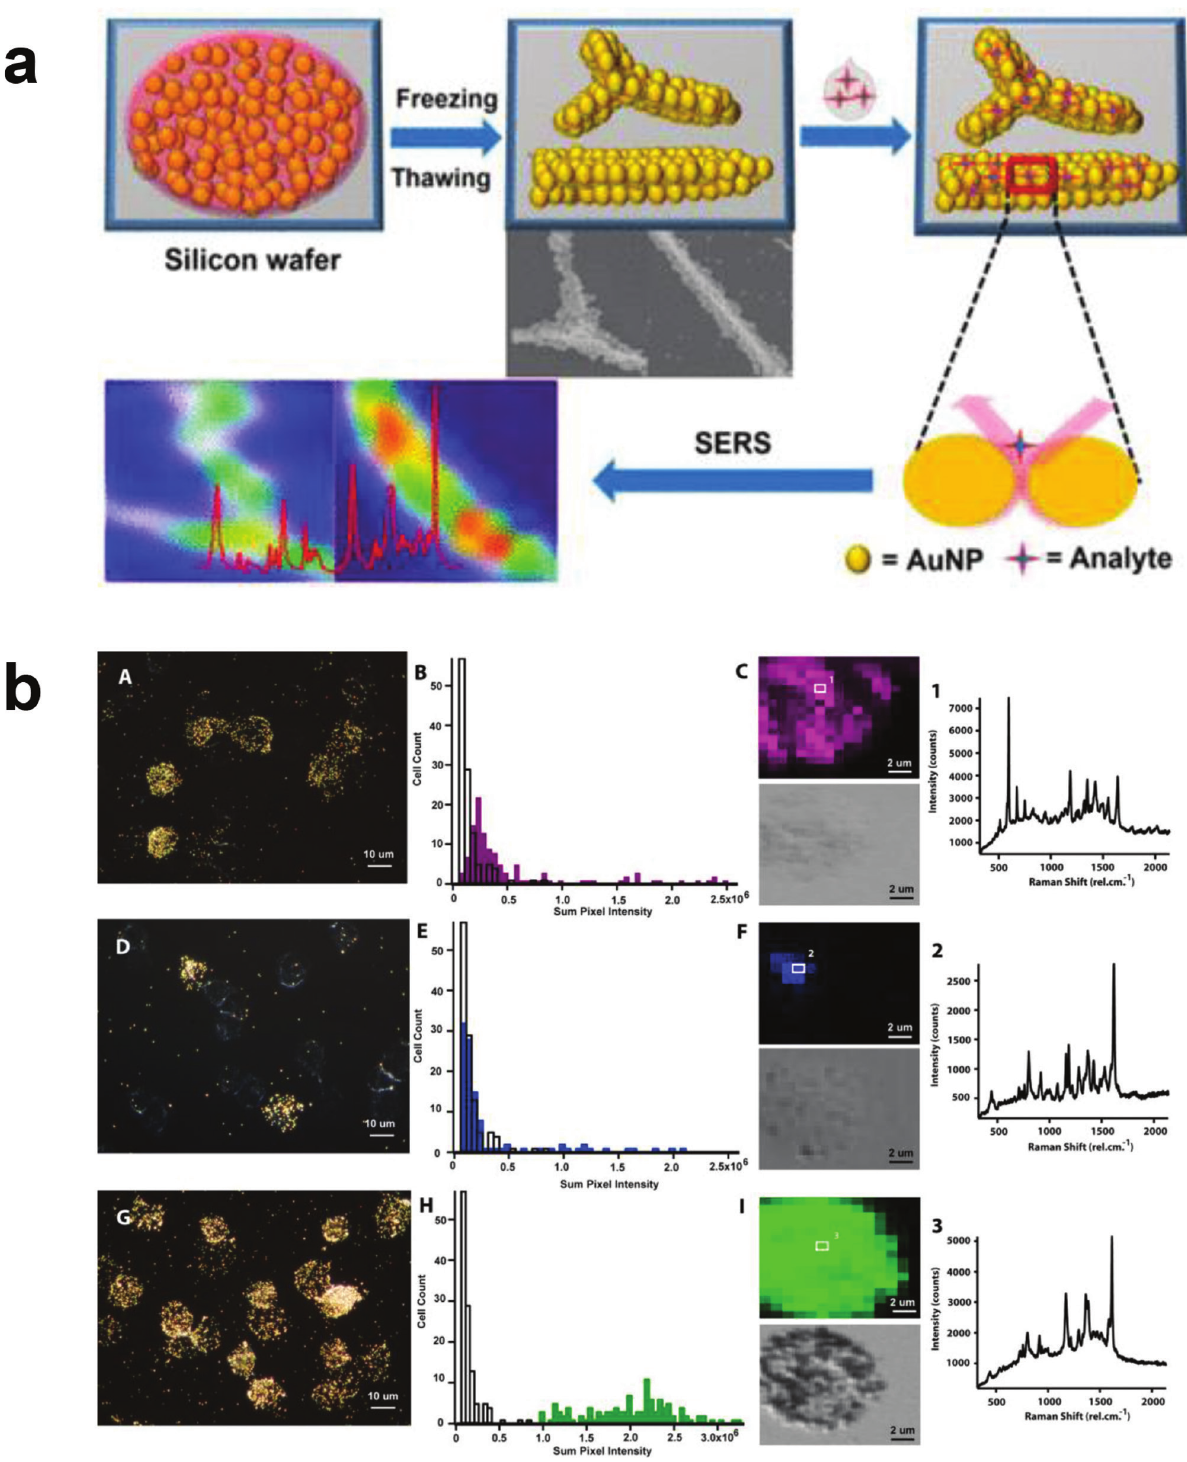
Fig. 2. (a) Plasmonic surface-enhanced Raman scattering (SERS) substrate made by using polycrystalline ice for assembly (39). (b) SERS-based imaging and analyzing of the LY10 B cell line